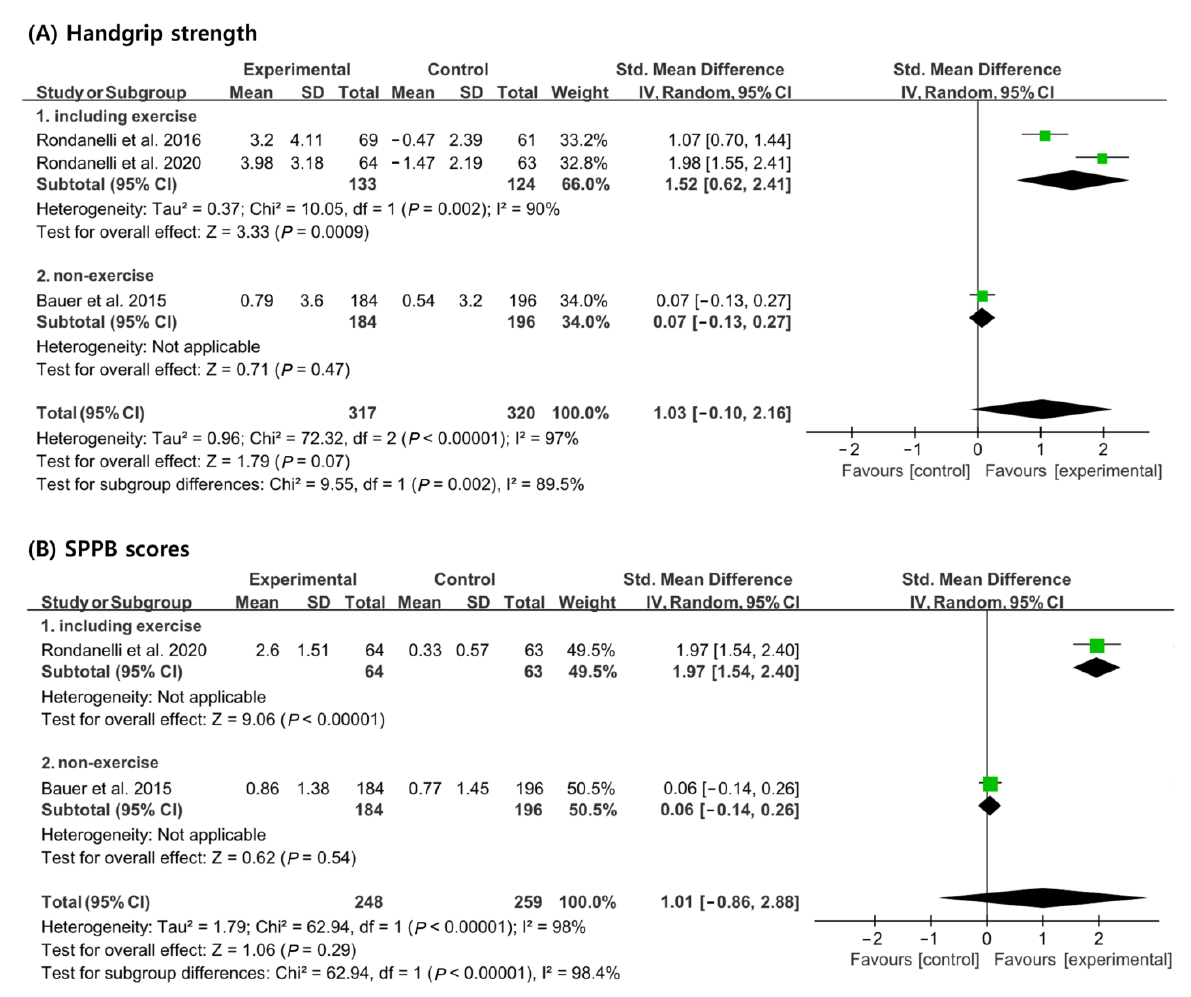
Figure 4. Forest plot showing the results of ( A ) handgrip strength [19–21] and ( B ) SPPB scores [19,21] after use of whey protein, leucine, and vitamin D in patients with sarcopenia. Numbers in bold indicate analysis results.